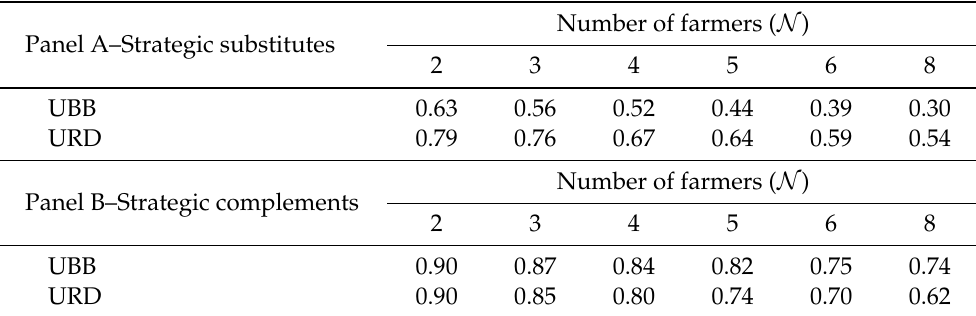
Table 2. Acceptance rates of the GW program with (Panel A) strategic substitutes and (Panel B) strategic complements (sub-sample = 1000).